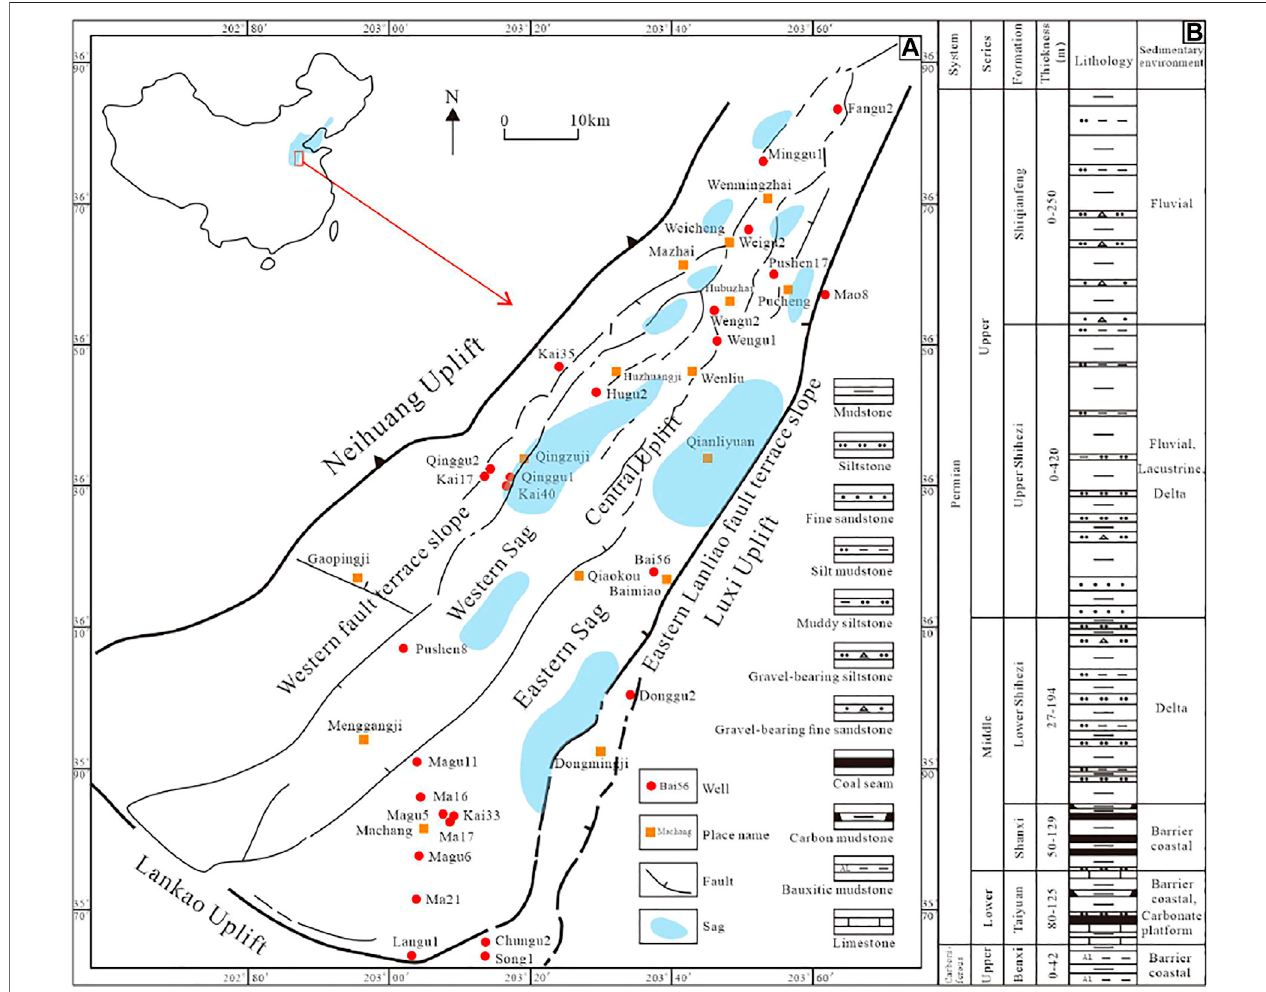
FIGURE 1 | (A) Regional location and structural unit division of the Dongpu Depression; (B) Simpli fi ed stratigraphic column of the Dongpu Depression (Modi fi ed after the Zhongyuan Oil fi eld).